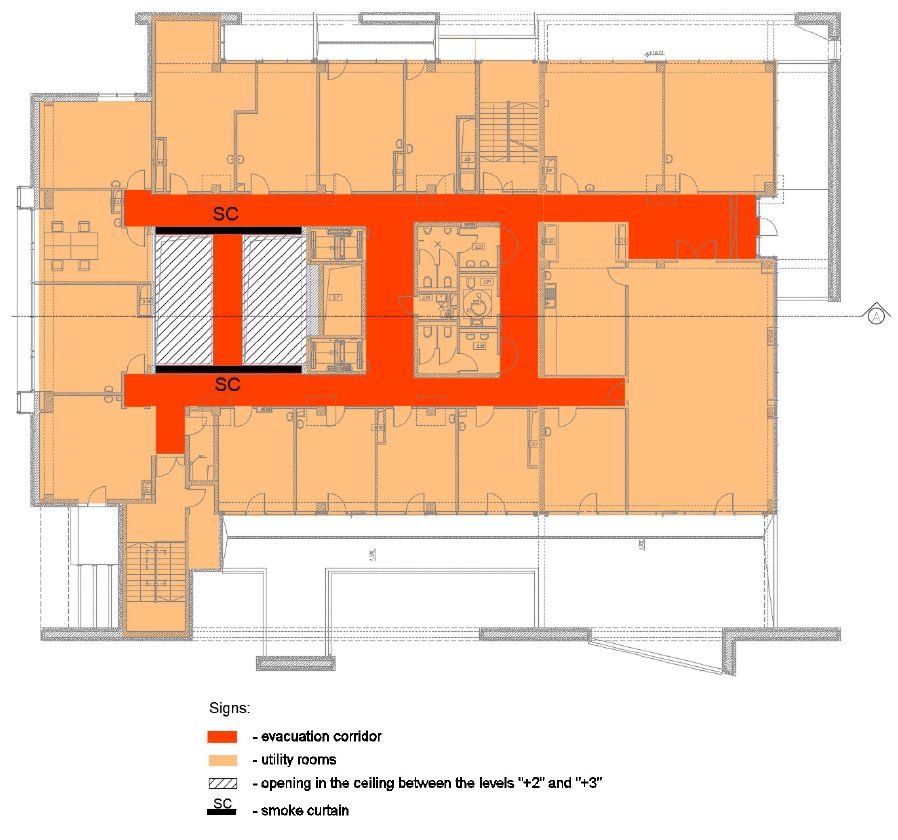
Figure 10. Atrium—Level 3.